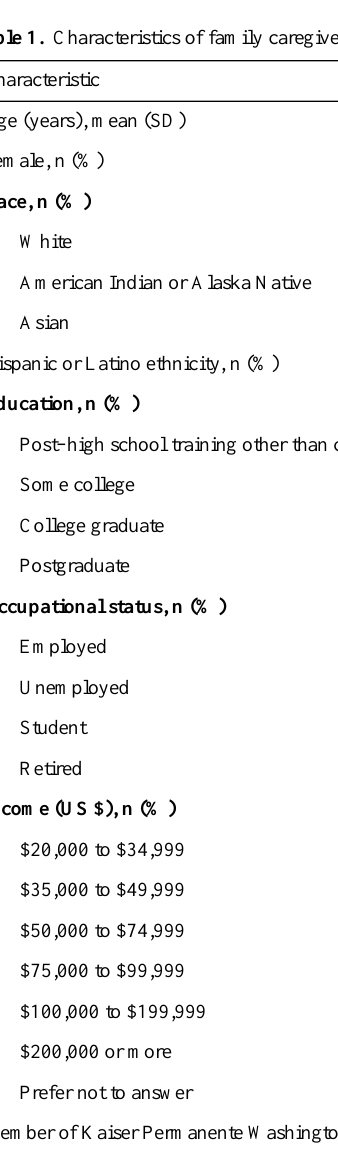
Table 1. Characteristics of family caregivers and description of the caregiving situation (N=15).